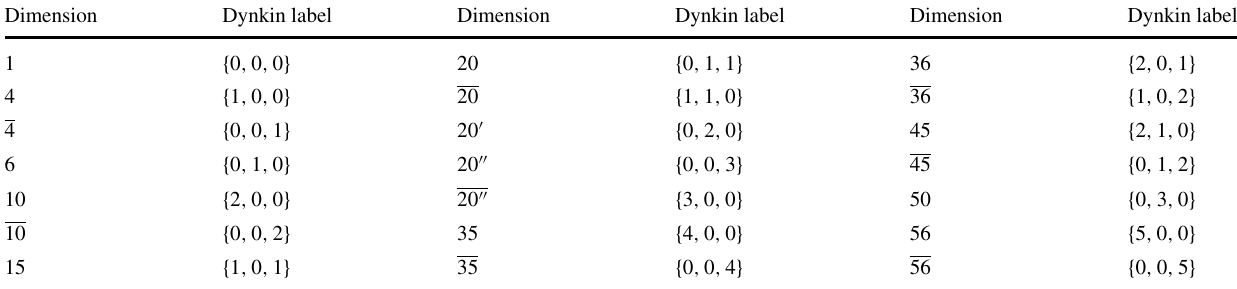
Table 59 Dynkin labels corresponding to a few low dimensional representations of SU ( 4 ) Dimension